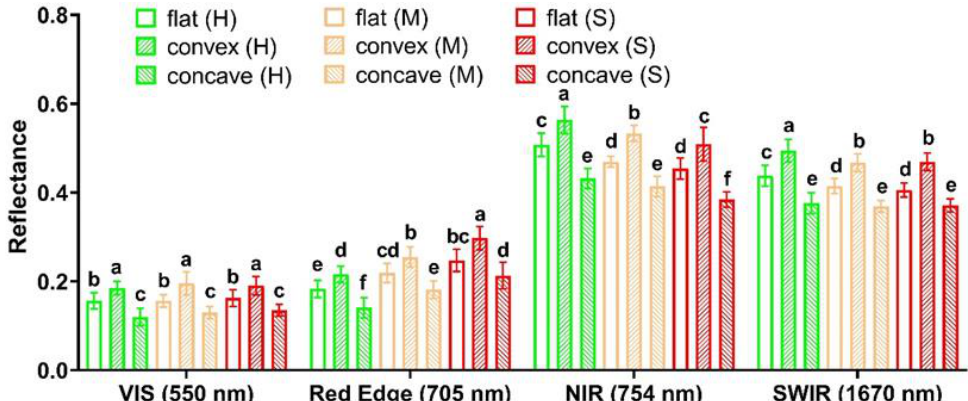
Figure 7. Reflectance values in Dataset (C) at selected wavelengths. H, M and S in the legend denote healthy, moderate and severe, respectively. Error bar denotes standard deviation. Letters above histograms mark the significances, and values with the same letter are not significantly different.